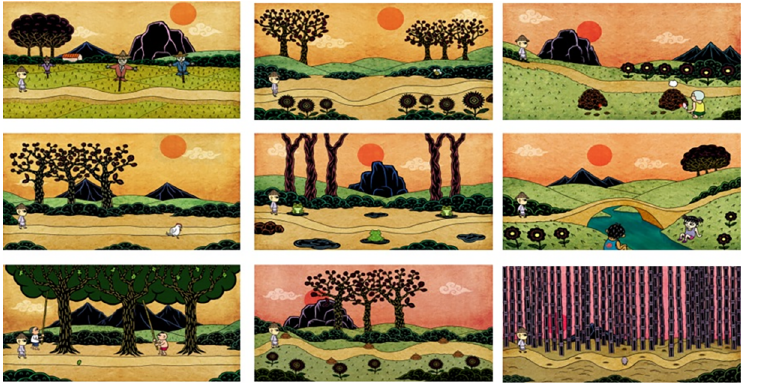
Fig 3. Ten Pretty Pass of the Bull.